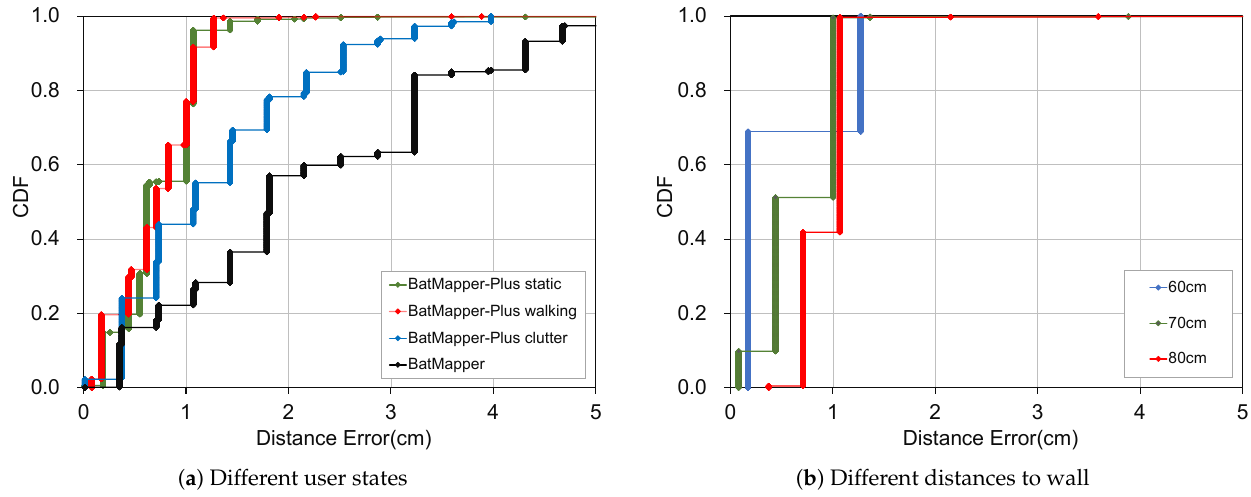
Figure 10. Errors of unilateral acoustic ranging. ( a ) represents the ranging errors of the user in different states. ( b ) represents the ranging errors of the user in different